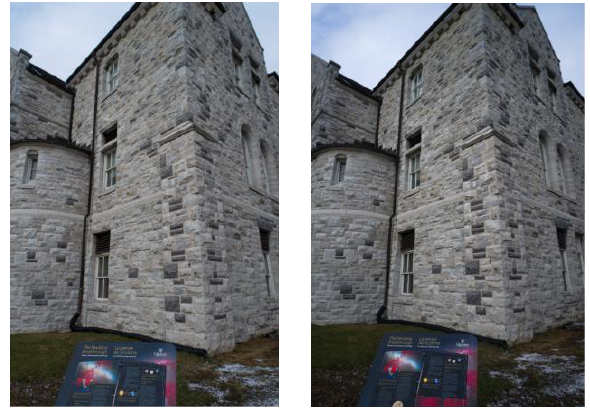
Figure 1. Visual comparison of DNG images when converted to JPEG with manufacturer supplied geometric correction imposed in Adobe (left), and with no geometric correction applied using RawTherapee (right).